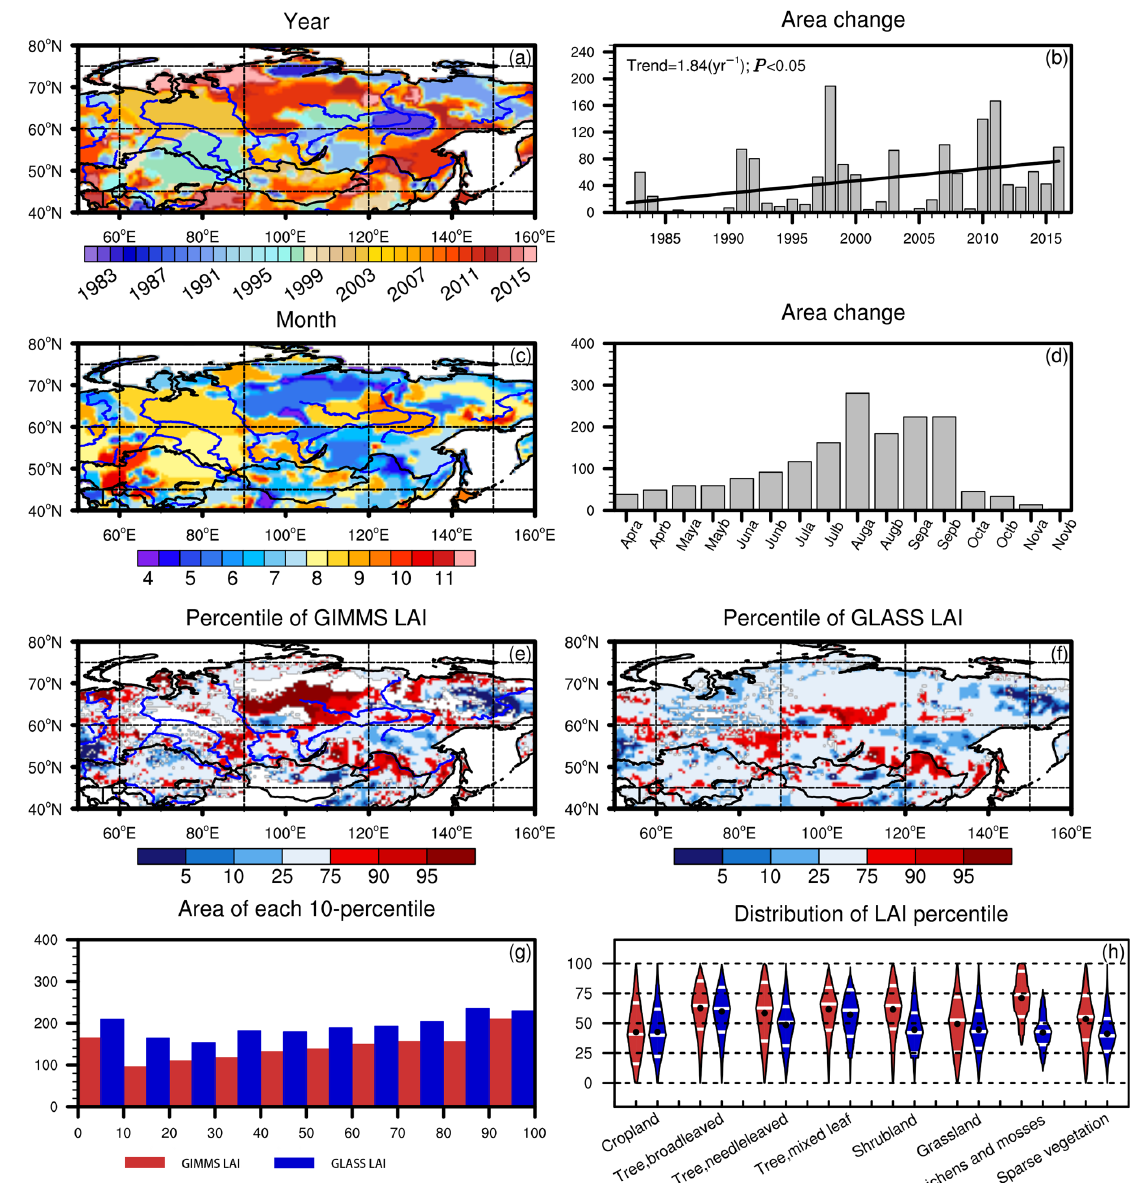
Figure 5. Years ( a ), half ‐ months ( c ), and percentiles of GIMMS LAI ( e ) and GLASS LAI ( f ) when the maximum 2 m temperature was recorded, and the corresponding accumulated areas (unit in 10 4 km 2 . ( b , d , g ). The box plot ( h ) shows the percentile of the LAI for different vegetation types, with the white lines showing the 25th, 50th, and 75th percentiles, and the dots showing the averages. The line in b is the linear trend calculated by least ‐ squares regression.